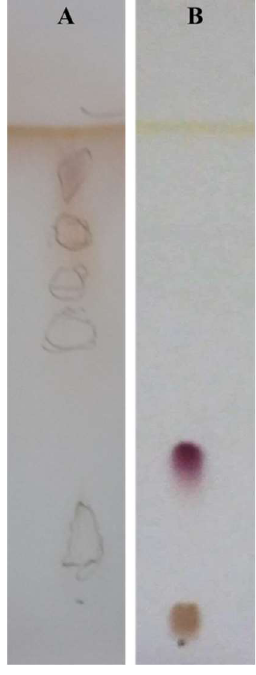
Figure 5. Thin layer chromatography analysis of the hydrolyzed biosurfactant ( A ) and the not-hydrolyzed biosurfactant ( B ) produced by R . opacus R7 developed with CH 3 Cl:Me(OH):H 2 O:CH 3 COOH [3:6:1:0.3] detected with